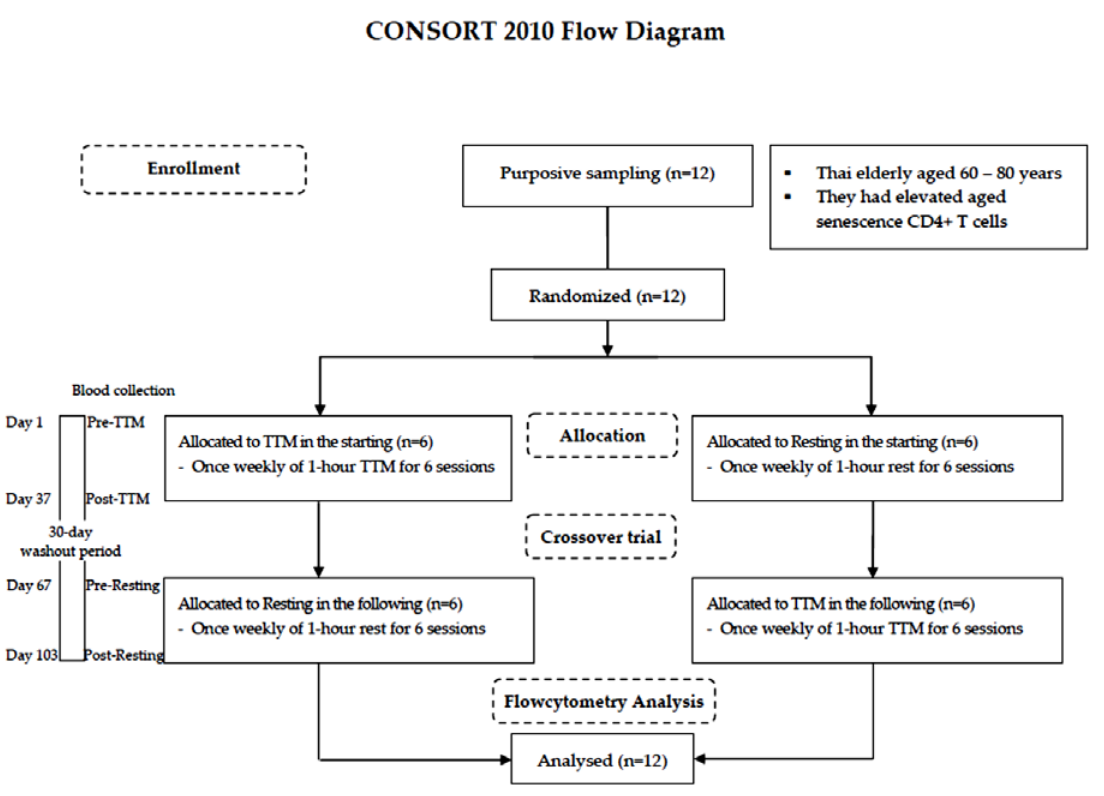
Figure 1. CONSORT 2010 flowchart diagram.